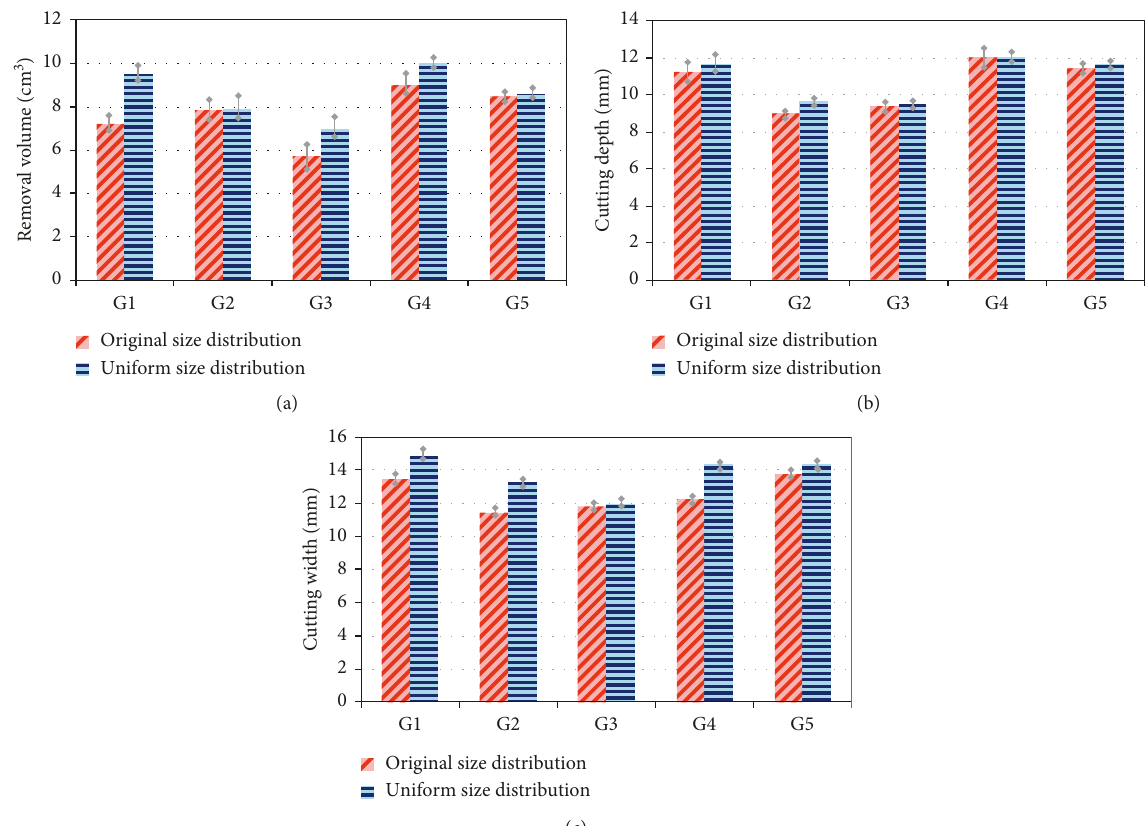
Figure 7: Cutting performance comparison between original size distribution and uniformed size distribution (0.425 mm): (a) removal volume; (b) cutting depth; (c) cutting